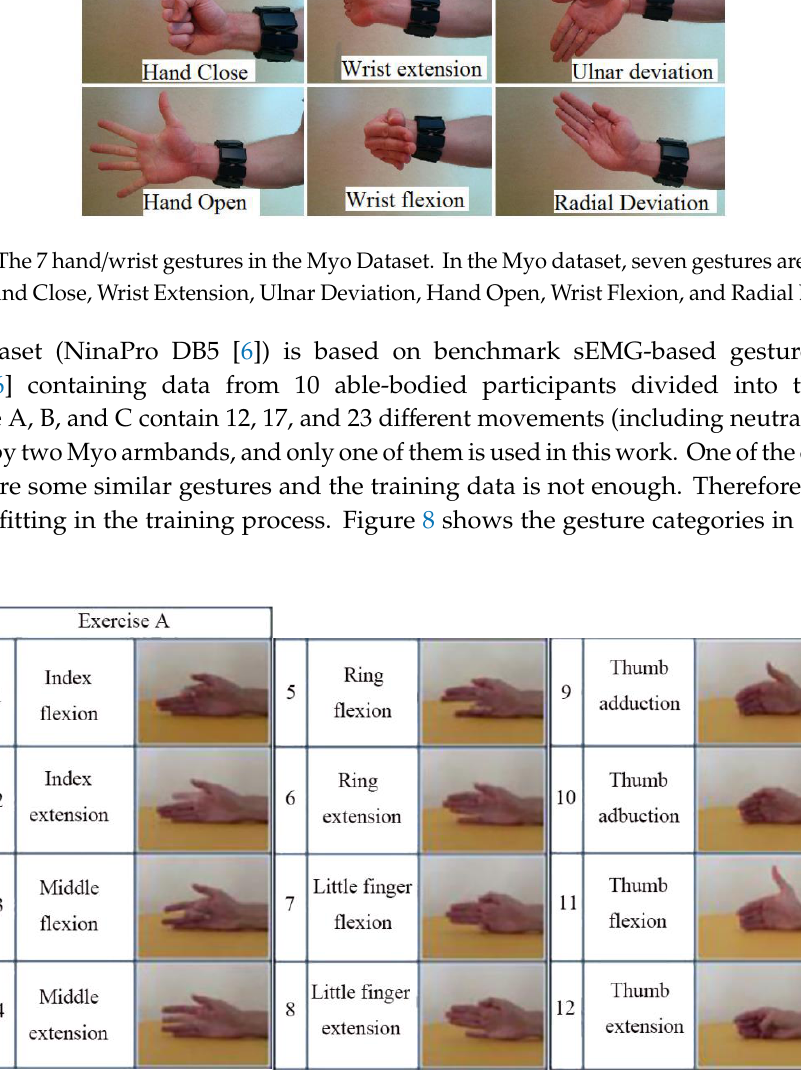
Figure 8. The gesture categories in the Exercise A dataset.